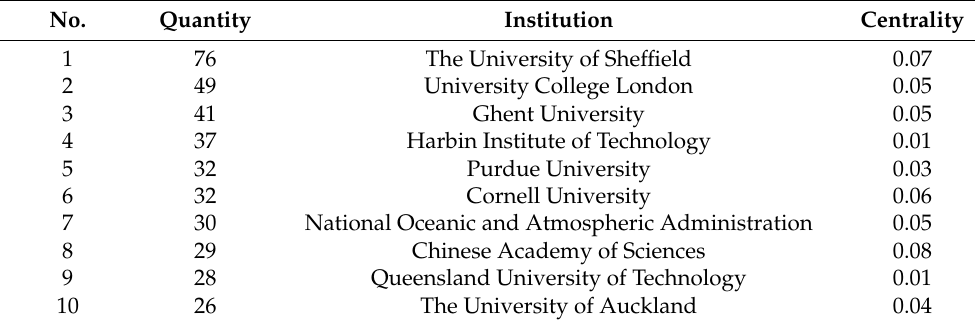
Table 1. Top 10 research institutions in the field of soundscape.